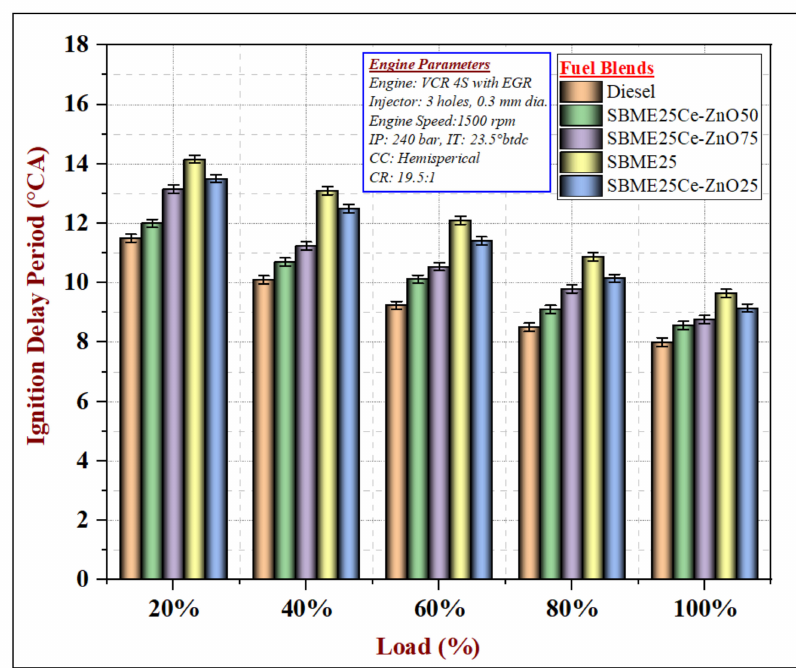
Figure 15. Variation of ID at di ff erent crank